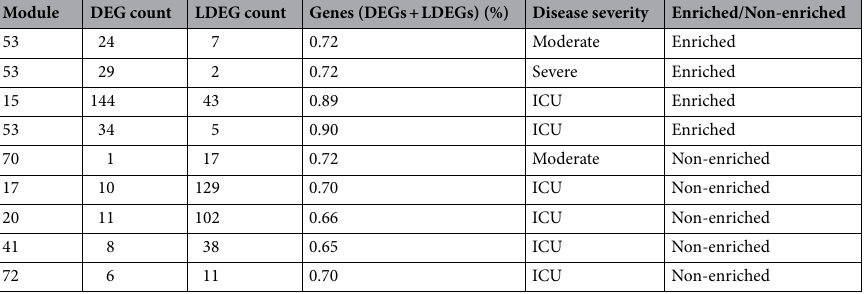
Table 1. Modules with over 65% genes either DEGs or LDEGs in moderate, severe, and extremely severe (ICU) SARS-CoV-2 infected humans relative to healthy humans.